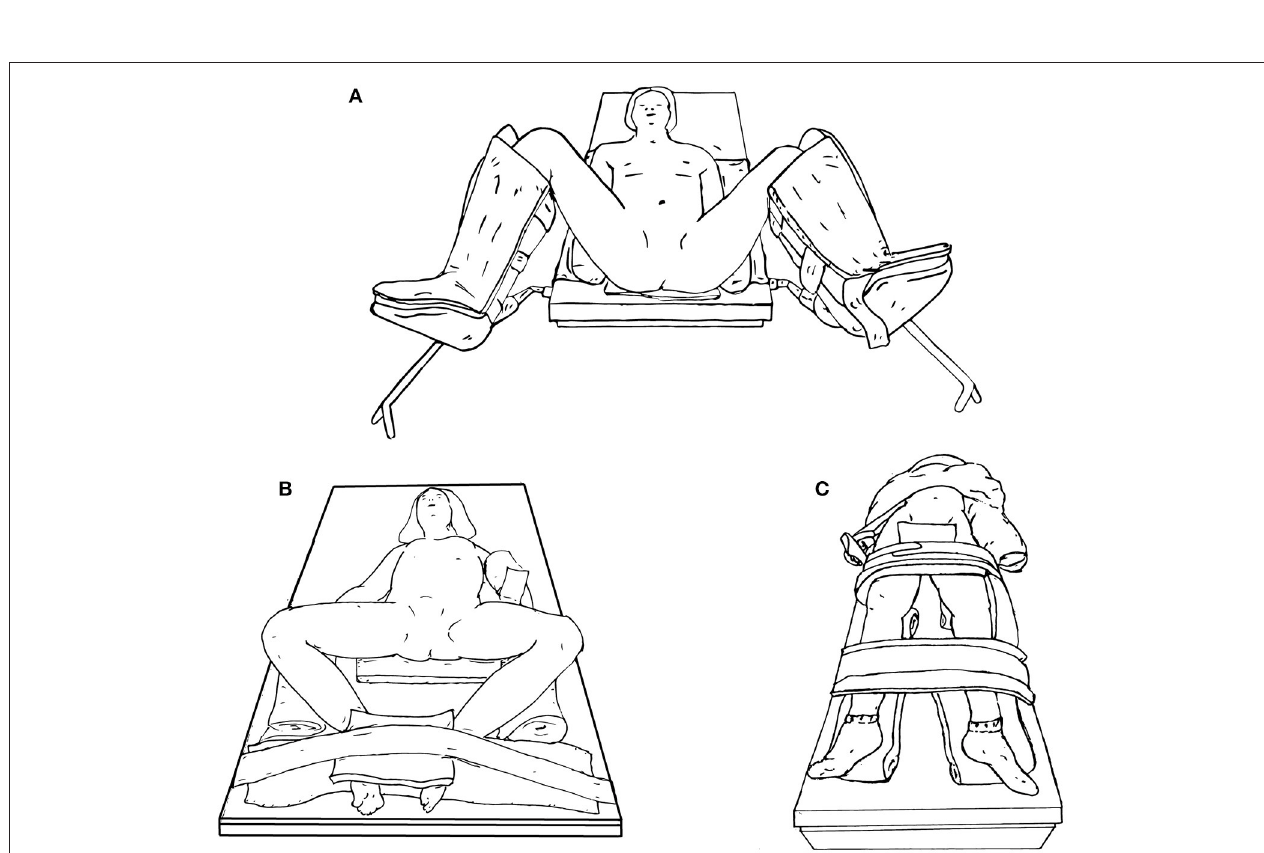
FIGURE 7 | Lower urinary tract surgery positioning options, including lithotomy (A) , frog-leg (B) , or supine (C) .